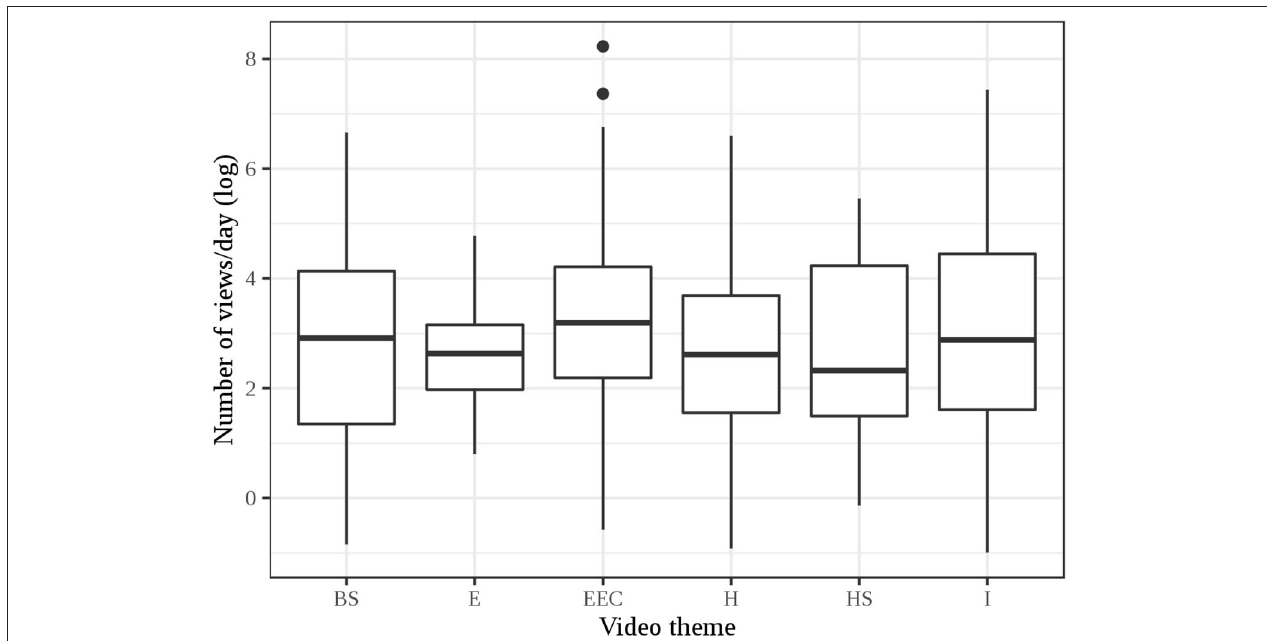
FIGURE 1 | Number of views per day (log) x video theme (dots refer to